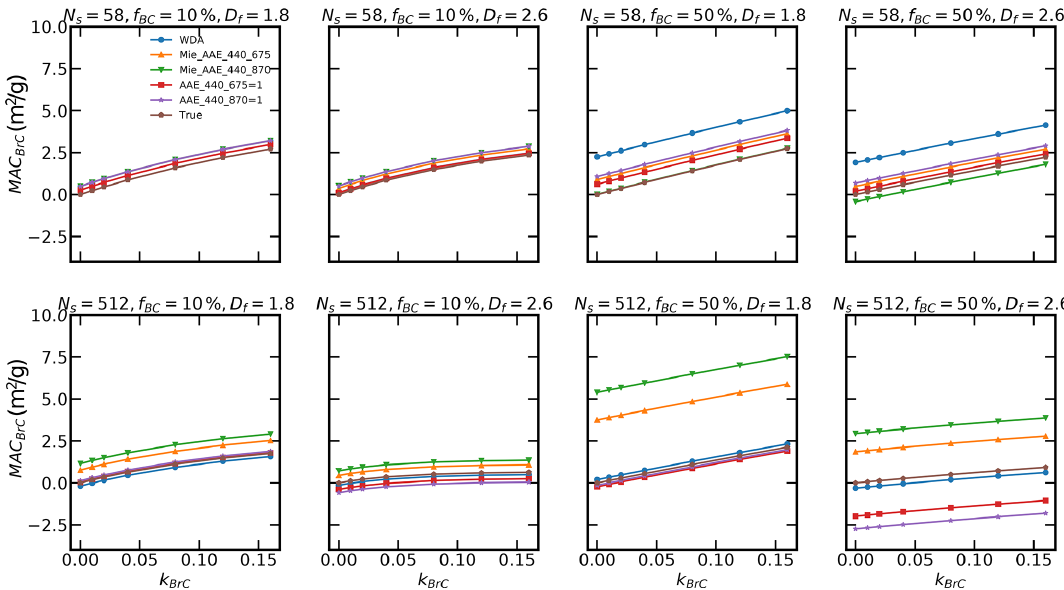
Figure 8. Comparison of the true and inferred BrC absorption for internally mixed particles (Model A; λ = 440nm).